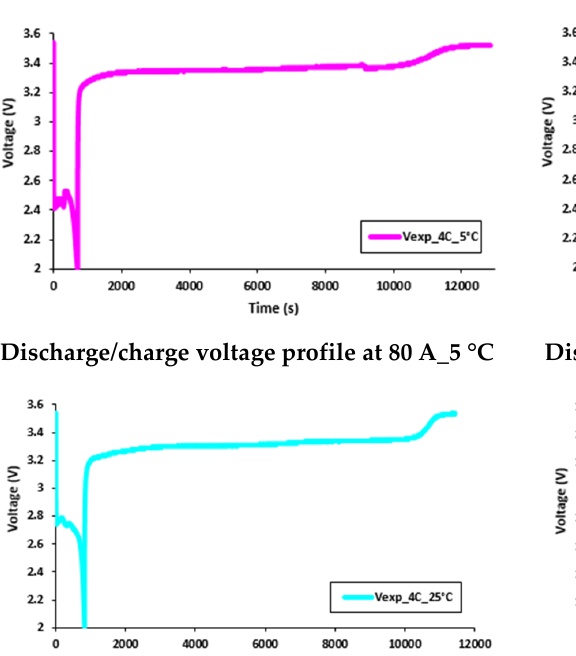
Figure 19. Discharge/charge voltage profile at 60 A with 5 °C, 15 °C, 25 °C, and 35 °C.